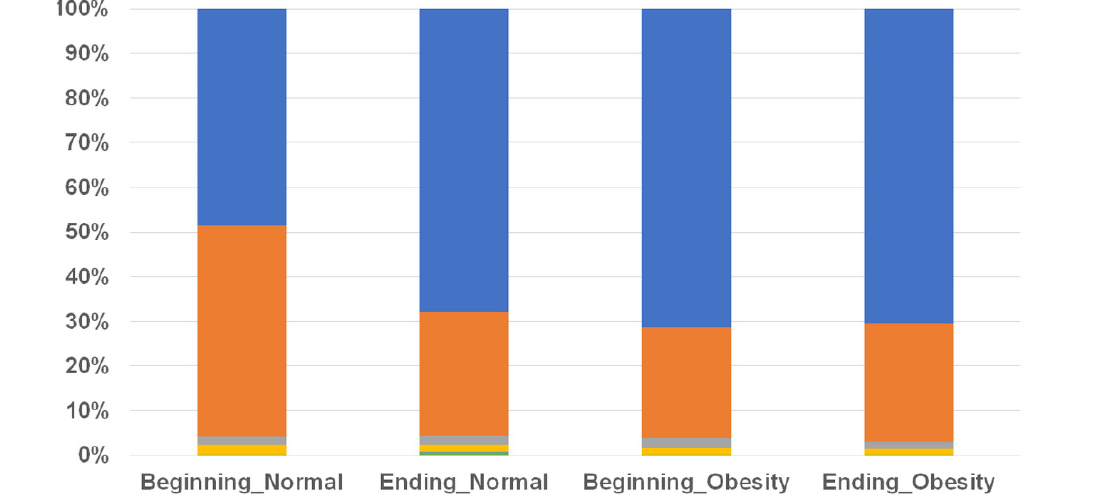
Figure 1. Relative abundance of bacterial phyla in fecal samples during nopal diet intervention. Data for normal weight and obese at beginning and ending of nopal diet. Sectors in bar plots indicate main phyla as shown by tag colors at the right side of the figure. Abundances of each bacterial phylum are shown as percentage in the Y-axis, and the groups names in the X-axis. “Other” include phyla with <0.50% relative abundance (Fusobacteria, Tenericutes, Verrucomicrobia, Chlorobi, Synergistetes, TM7, Thermi, Lentisphaerae, Chloroflexi, Acidobacteria, Fibrobacteres, Nitrospirae, Spirochaetes)—see Table S2.